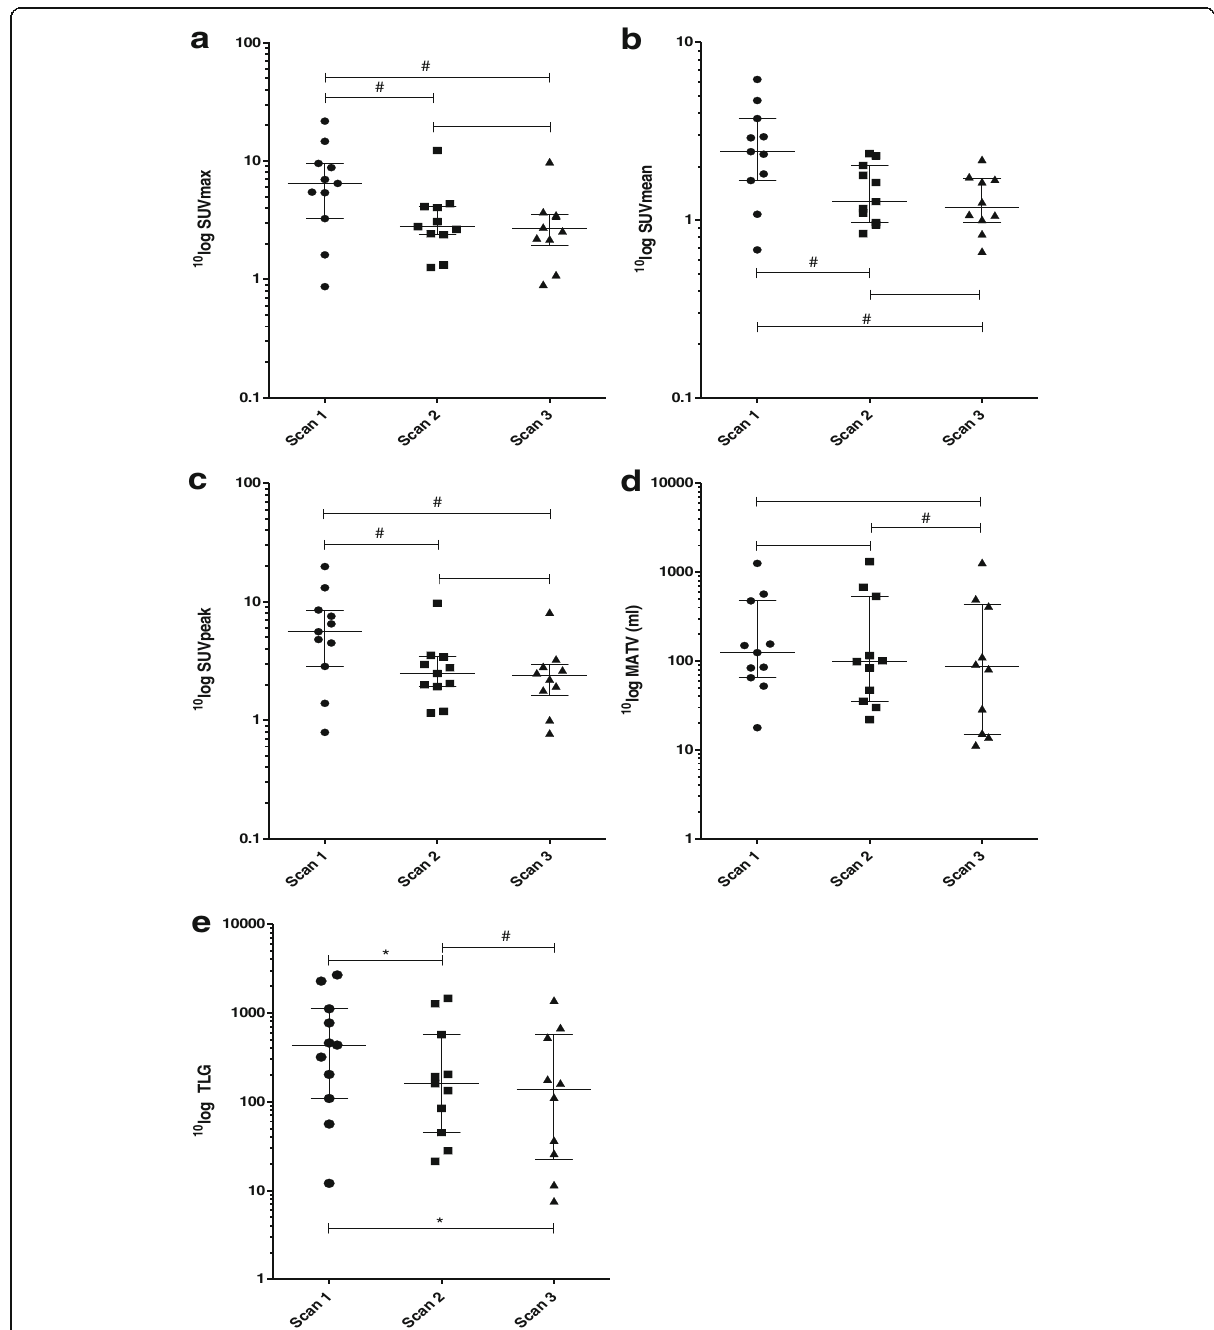
Fig. 4 Changes in metabolic tumor activity (VOI man ) during neoadjuvant treatment for the serial 18 F-FDG PET-CT scans. Changes in metabolic tumor activity for the VOI man during the neoadjuvant treatment for the serial 18 F-FDG PET-CT scans. Median and interquartile ranges are indicated. a SUV max . b SUV mean . c SUV peak . d Metabolically active tumor volume (MATV). e Total lesion glycolysis (TLG). * p <0.05; # p